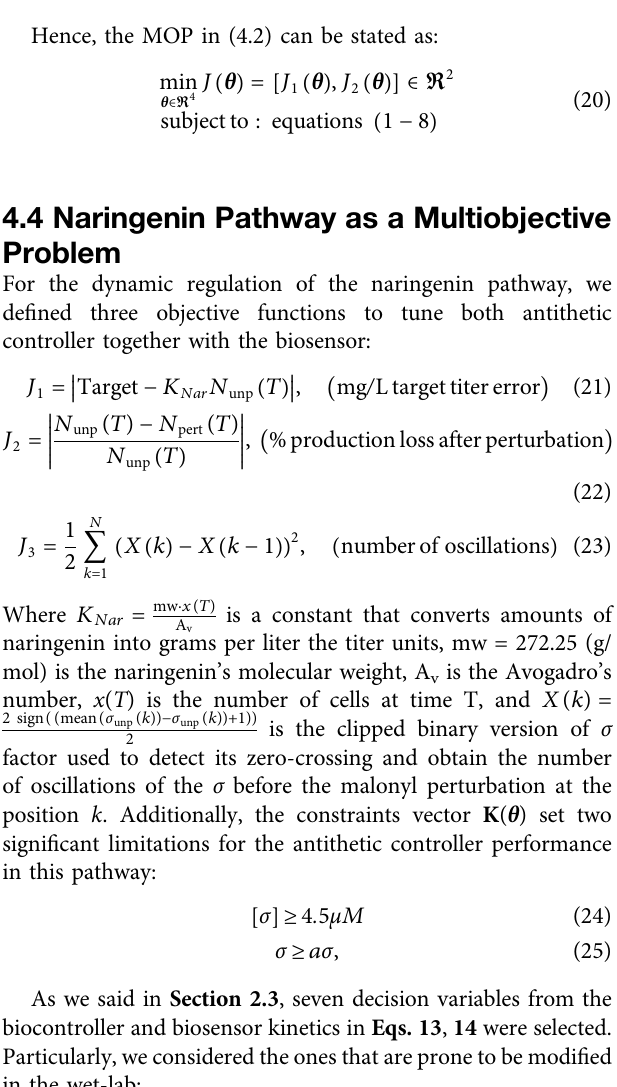
Table 2 de fi nes the lower and upper limits of the parameters